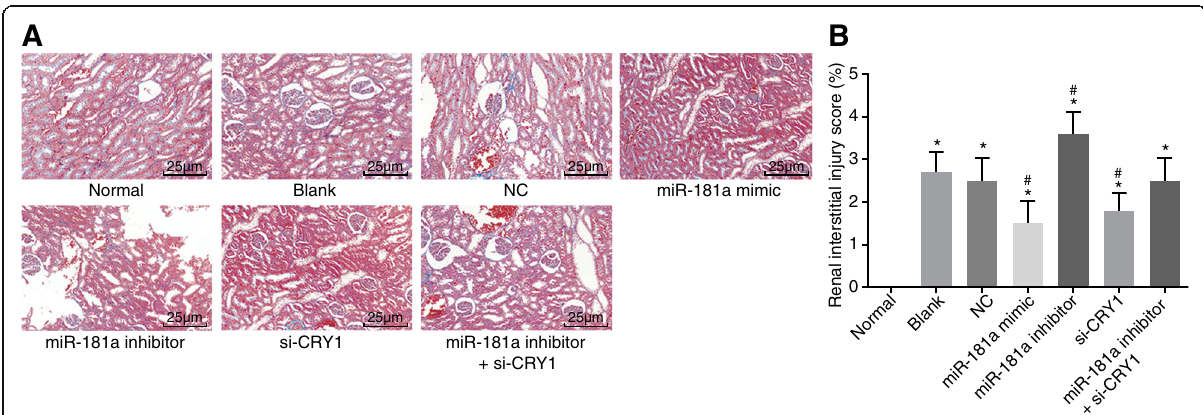
Fig. 6 Masson staining (× 400) shows that up-regulated miR-181a or down-regulated CRY1 reduces the degree of tubulointerstitial lesions. Notes: Panel a , results of Masson staining under a microscope; Panel b , histogram of Masson results; * , p < 0.05 vs. the normal group; # , p < 0.05 vs. the blank and NC groups; the data are presented as the mean ± standard deviation, analyzed by one- way ANOVA; the experiment was independently repeated three times; NC, negative control; miR-181a, microRNA-181a; CRY1, cryptochrome 1